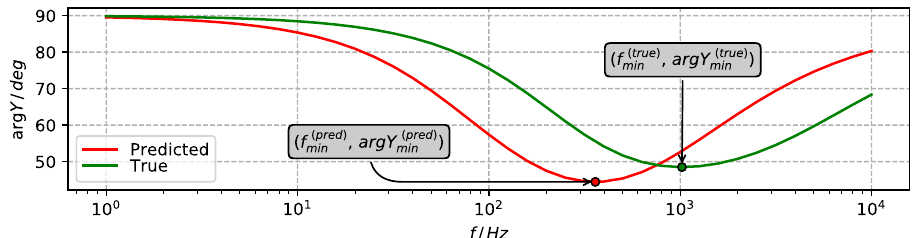
Figure 5. Spectral features of modeled EIS spectra involved in quantifying the difference between true and predicted defect set